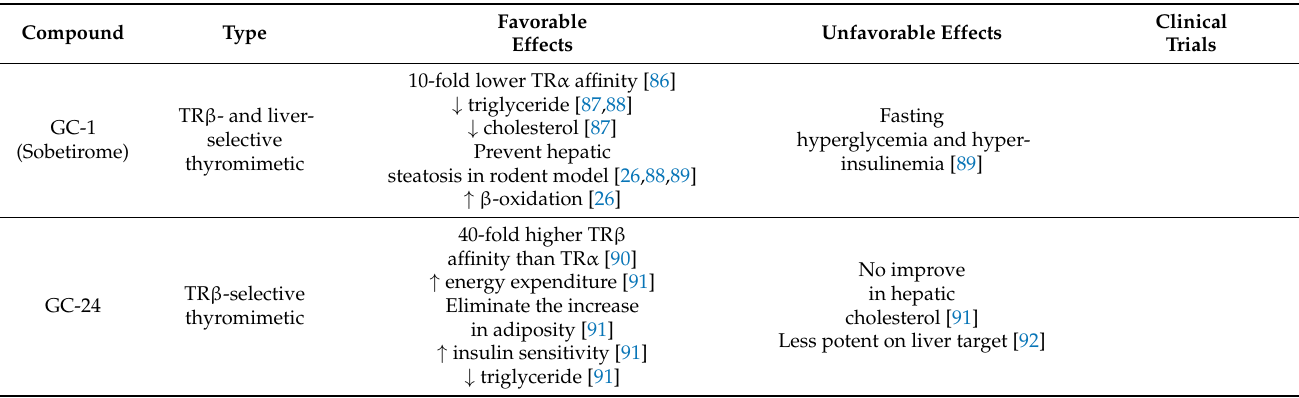
Table 1. Summary of